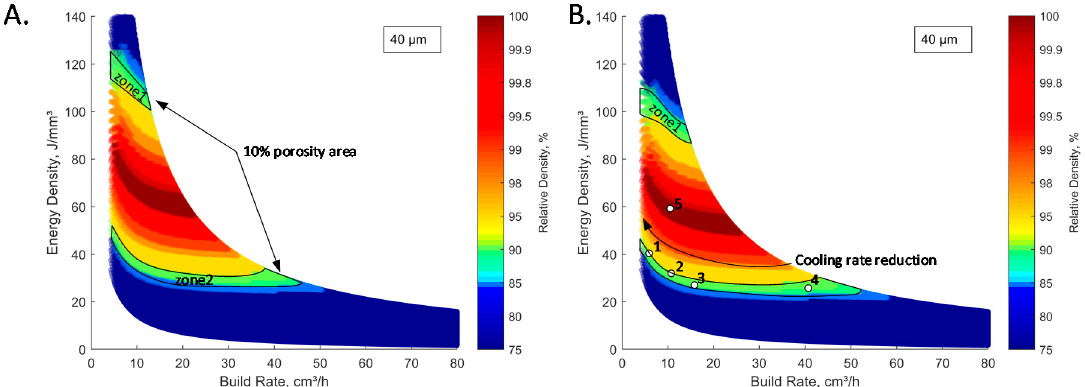
Figure 2. Calibrated density processing maps: ( A ) unheated and ( B ) heated (200 °C) build plates; Specimens 1–4 correspond to a target density of ~90%; Specimen 5 corresponds to a ≥ 99.9% reference density.